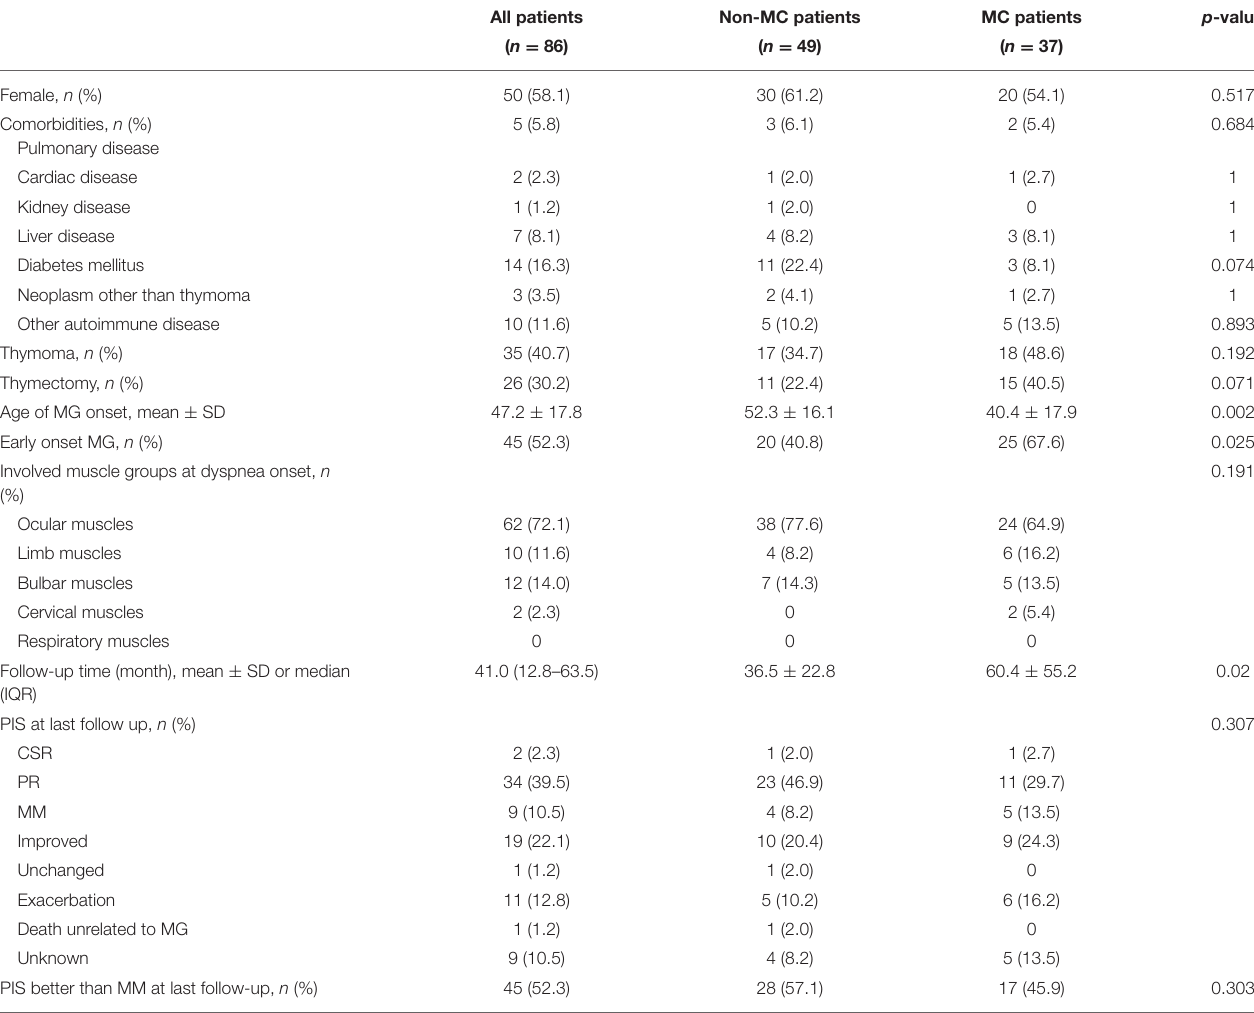
TABLE 3 | The clinical characteristics and prognosis of patients with and without MC during the MG course. All patients Non-MC patients MC patients p